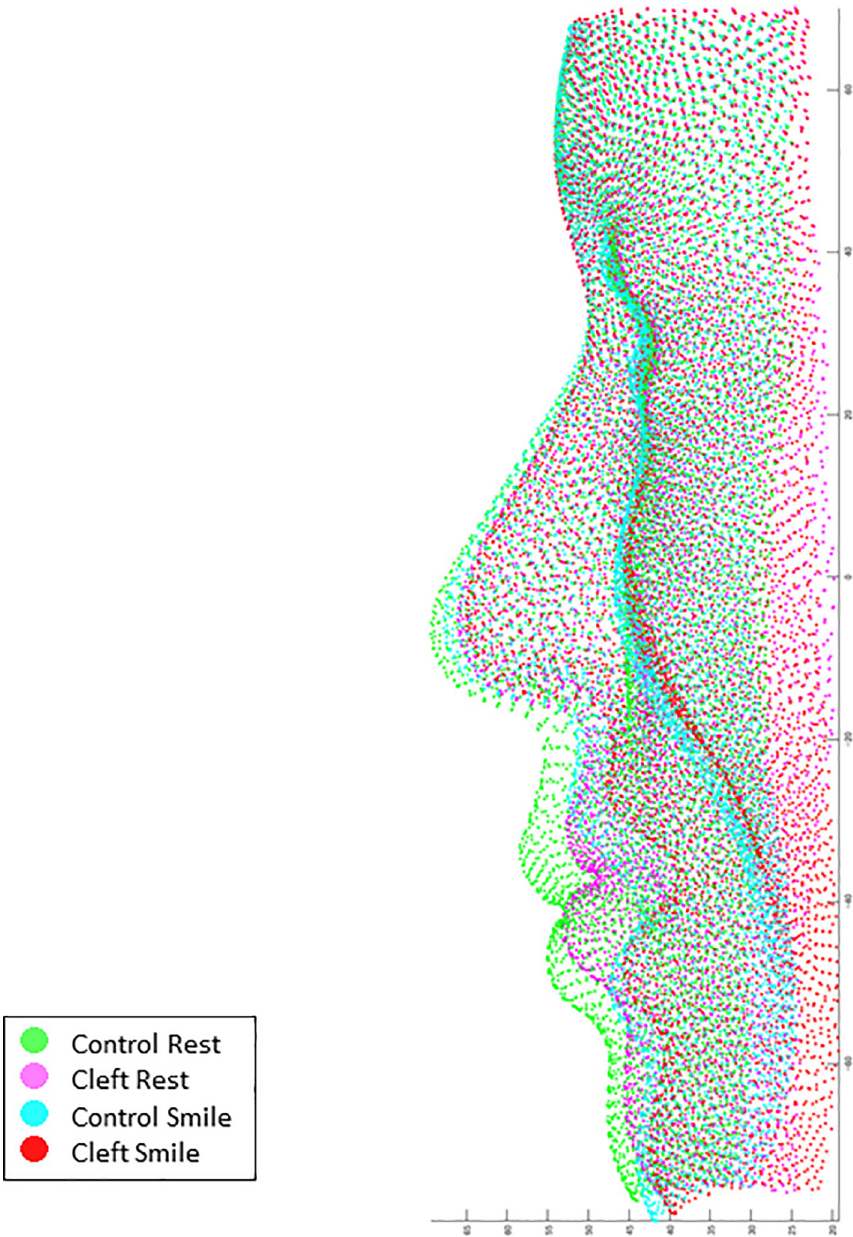
Fig 5. Superimposition of the average coordinate values of the Control group at rest posture (green), the Cleft group at rest posture (pink), the Control group at the peak of smiling (cyan), and the Cleft group at the peak of smiling (red).